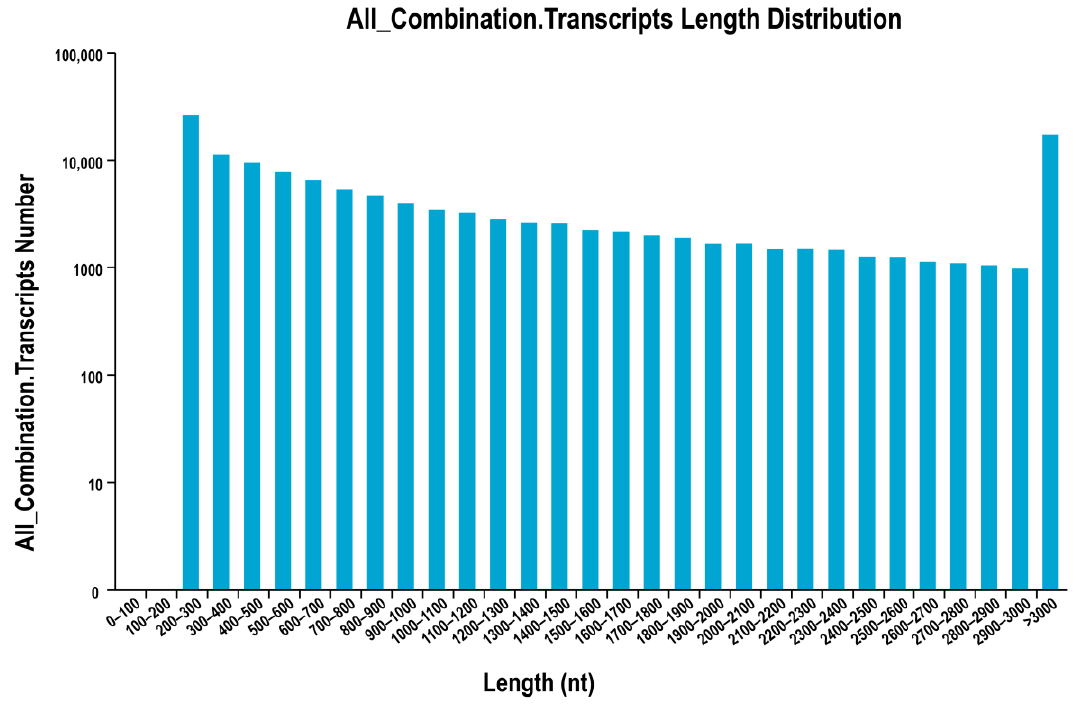
Figure 1. UniGene length distribution of Andrias davidianus.